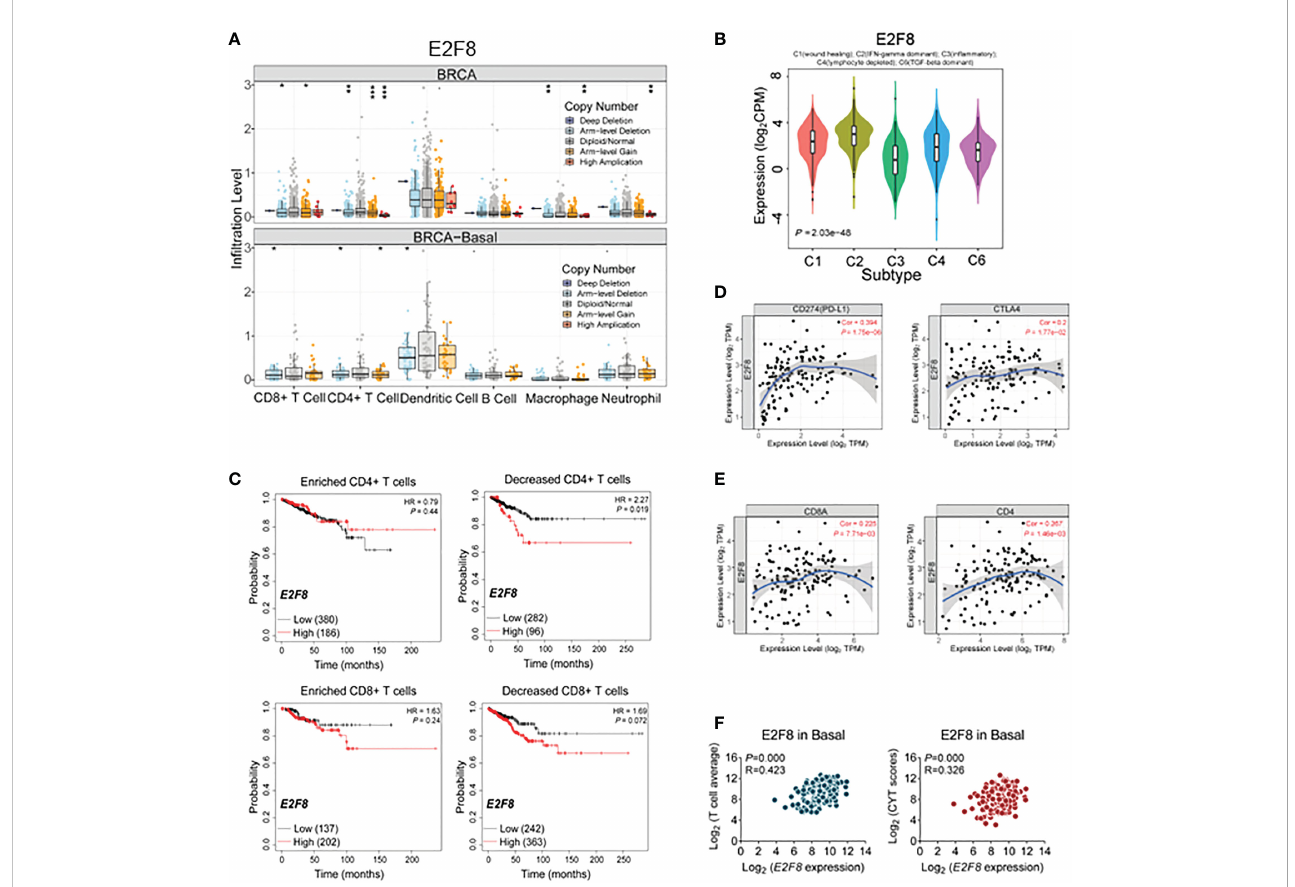
FIGURE 4 The immune cellular in fi ltrate analysis in breast cancers. (A) The cellular in fi ltration-level analysis in high expression of E2F8 in basal-like subtypes and breast cancer (BRCA) by the TISIDB database. (B) The correlation between E2F8 expression and immune subtype analysis in invasive breast cancers. The classic classi fi cation is as follows: C1 (wound healing), C2 (IFN- g dominant), C3 (in fl ammatory), C4 (lymphocyte depleted), C5 (immunologically quiet), and C6 (TGF- b dominant). (C) The overall survival (OS) analysis of patients suffering from invasive breast cancer by Kaplan – Meier plotters. The OS groupings covered enriched or decreased immune cells in the patients who had “ high ” or “ low ” expression of E2F8. (D) The correlation between E2F8 expression and immune checkpoint molecules (PD-L1 and CTLA4). (E) The correlation between E2F8 expression and CD8A/CD4. (F) The correlation between E2F8 expression and T-cell average/CYT